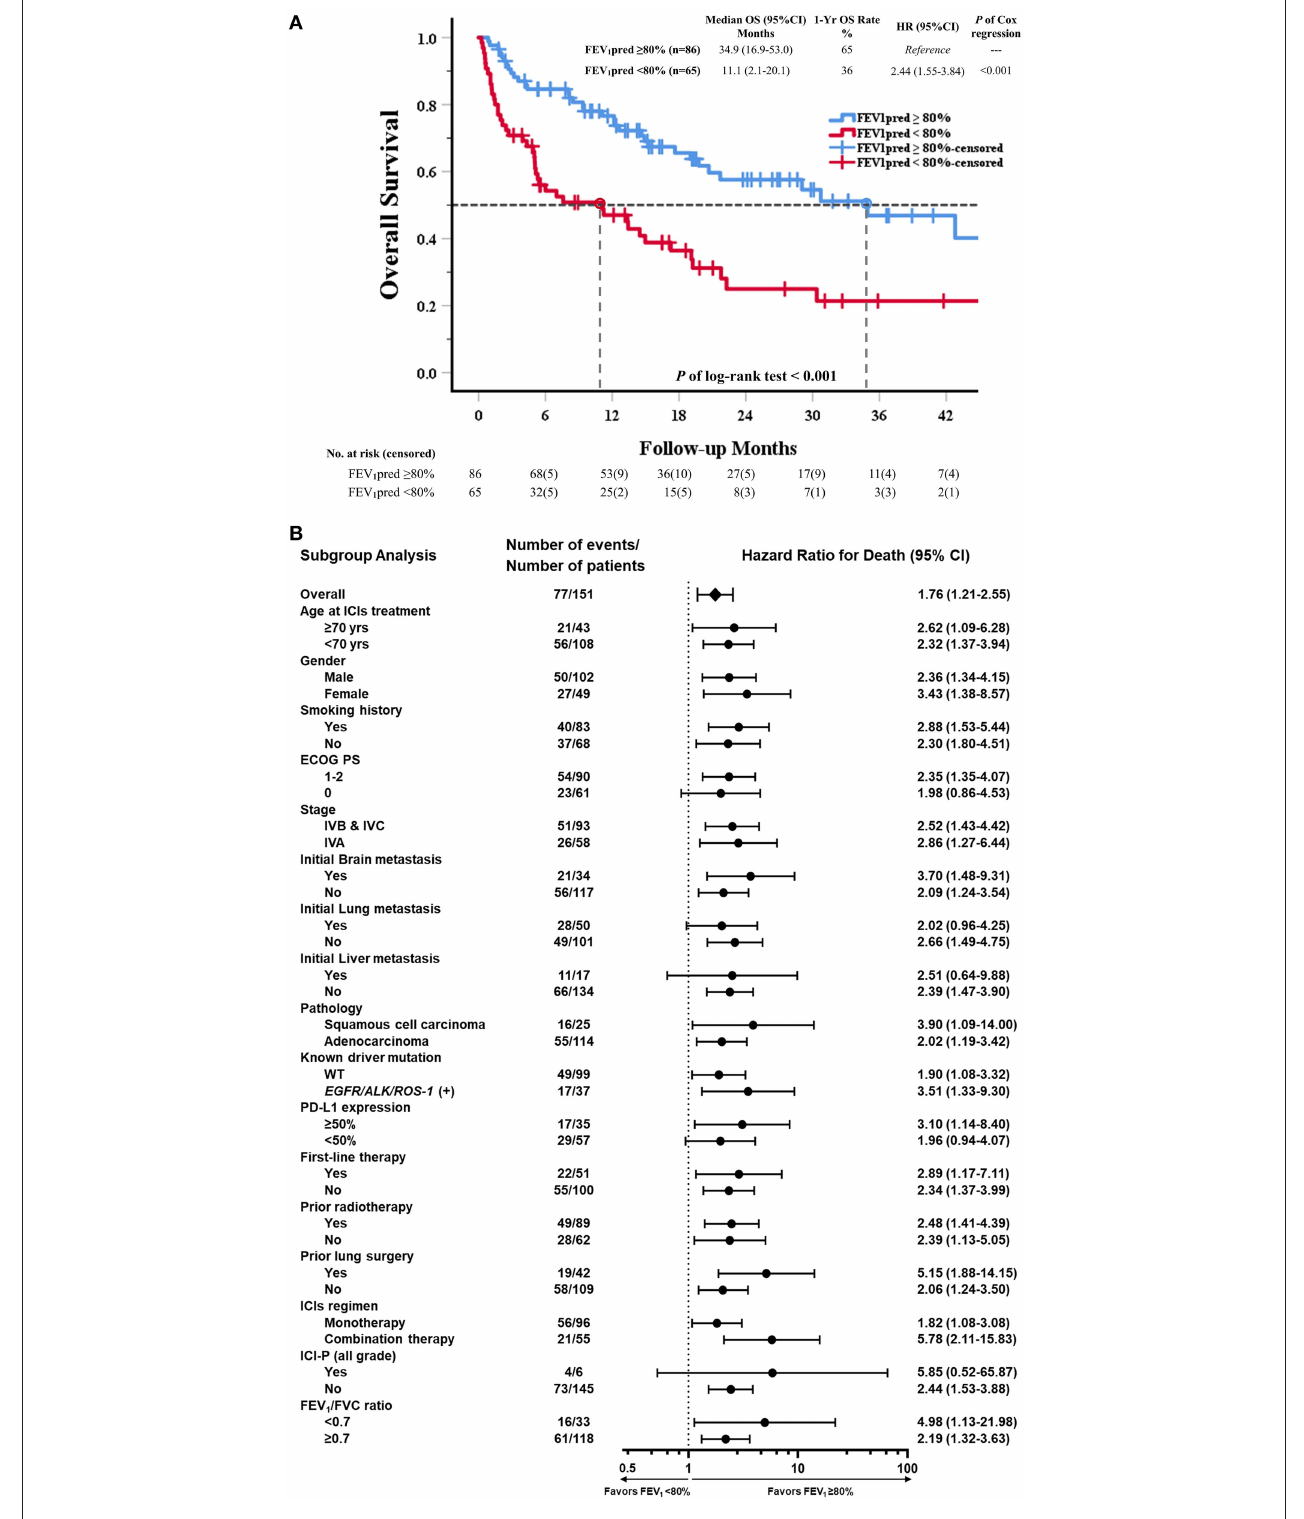
FIGURE 3 | Kaplan–Meier curve of OS and subgroup analysis of OS in all patients received ICI (80% of predicted FEV 1 as a cut-off value of FEV 1 ). (A) The Kaplan–Meier curve estimates of OS, according to using 80% of predicted FEV 1 as a cut-off value. Tick marks represent data censored at the last time the patient was known to be alive. (B) The data sheet and Forest plot shows the analysis of OS in all subgroups. Vertical dotted line in subgroup analysis represents HR, showing OS benefit for FEV 1 pred ≥ 80% compared with FEV 1 pred < 80% in all subgroups evaluated.